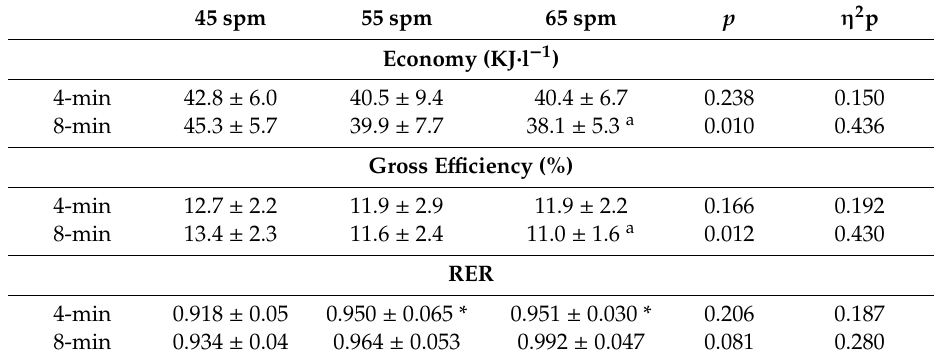
Table 2. Economy, gross e ffi ciency, and RER variables of SUP Paddlers at 4-min and